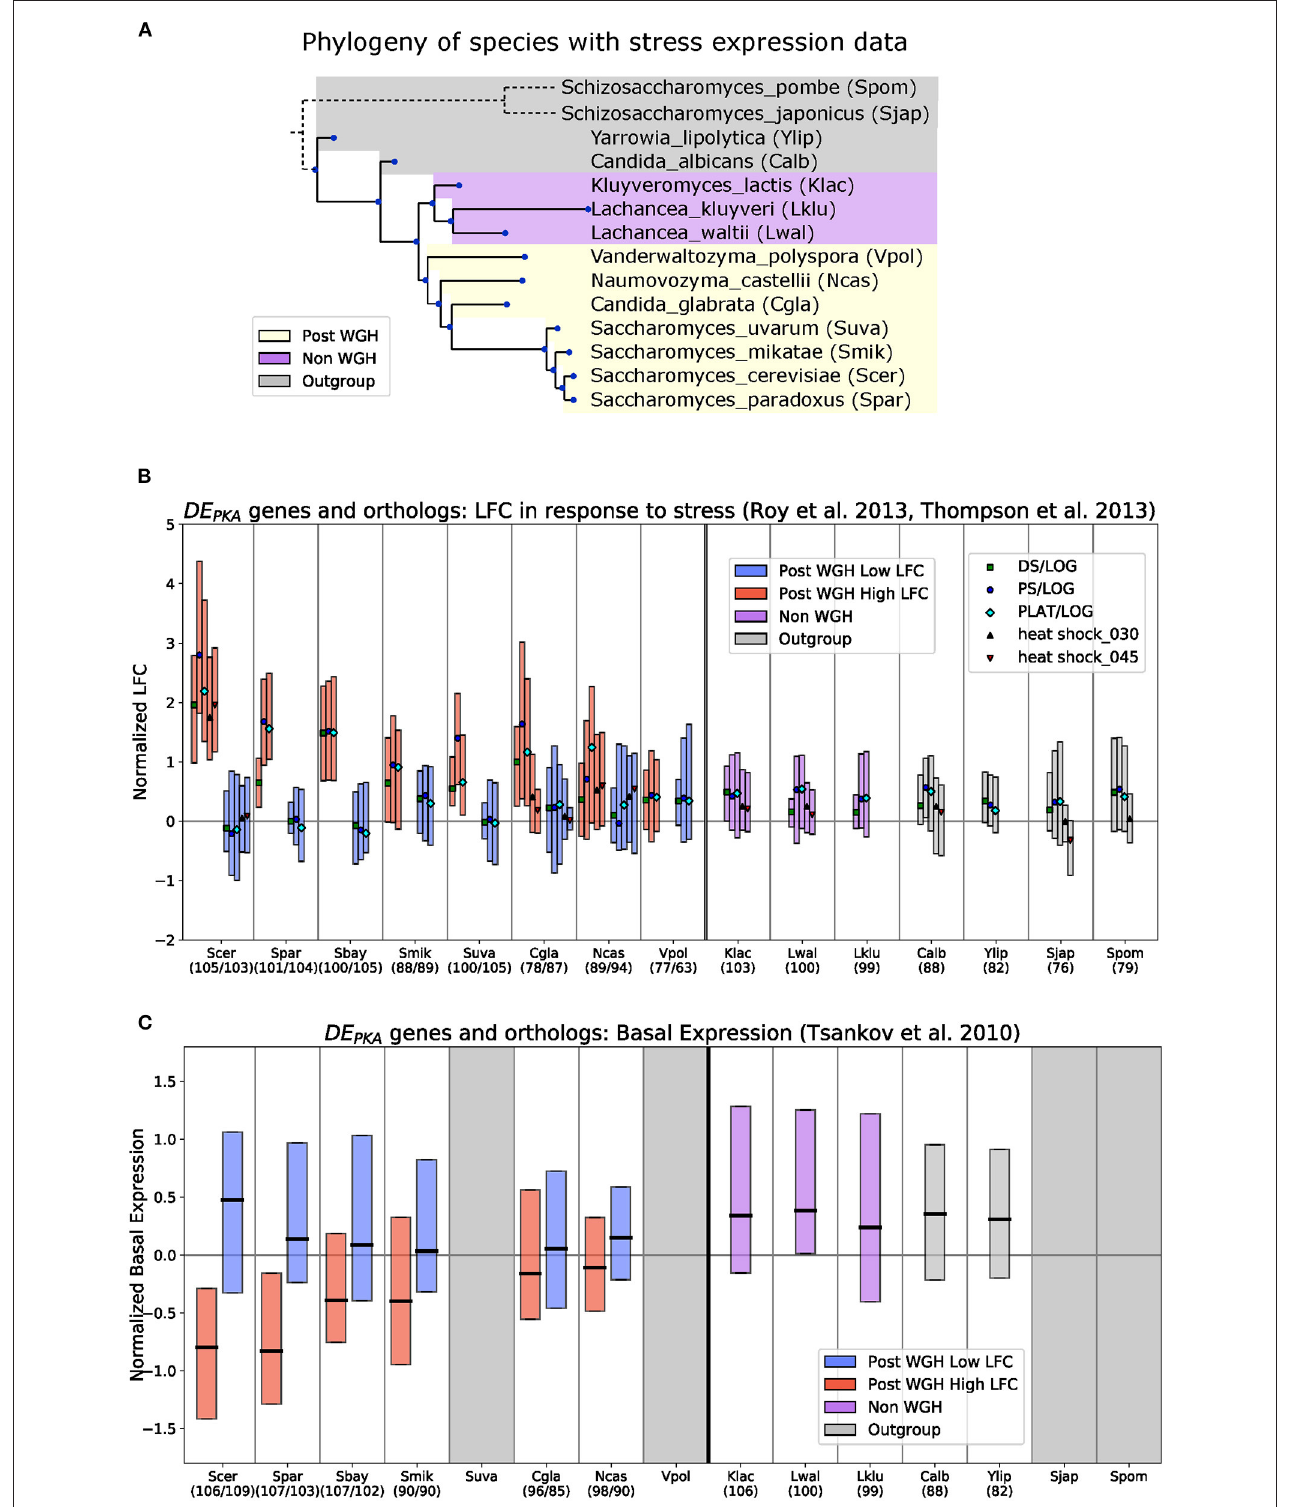
FIGURE 3 | For DE PKA genes, low LFC in response to PKA related stress and moderate basal expression is the ancestral phenotype. (A) Phylogeny of species with stress expression data used in (B) based on the time calibrated tree generated in Shen et al. (2018). S. bayanus is not shown because it is a hybrid